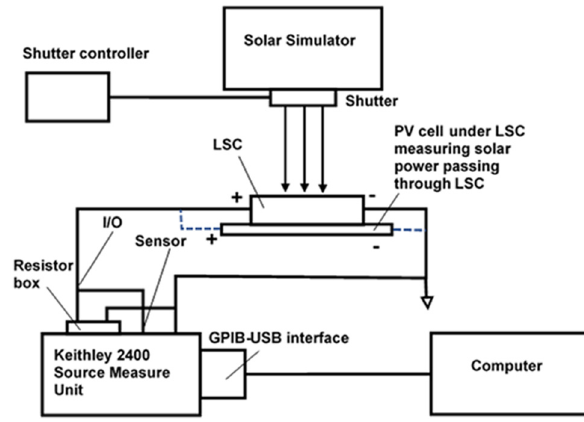
Figure 11: Block diagram of the experimental setup to measure I – V characteristics of the LSC.